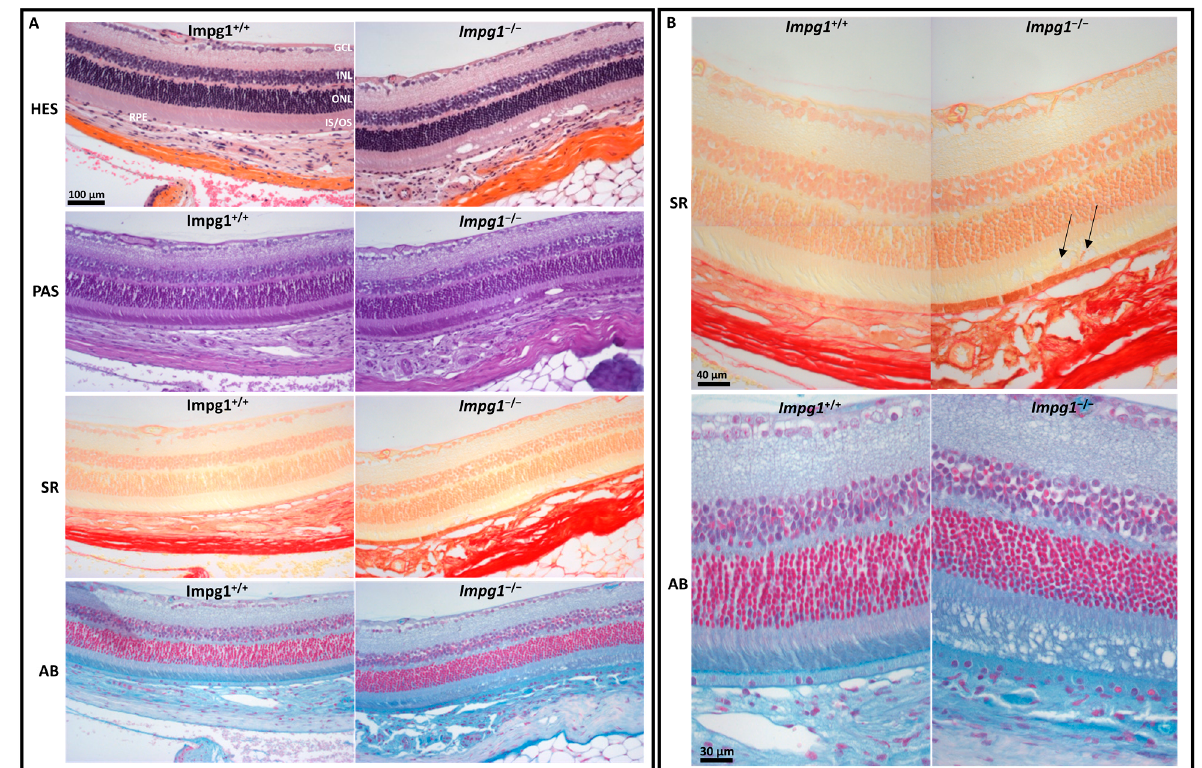
Figure 5. Disorganization of the IPM. ( A ) Histological staining of 14-month-old mouse retina showing IPM disorganization in the Impg1 − / − mice. Retinal sections were stained with Hematoxylin/Eosin/Saffron (HES), Periodic Acid Schiff (PAS), Sirius Red (SR), and Alcian Blue (AB) to evaluate the nature of the material abnormally localized in the IPM; magnification ×20. ( B ) Sirius Red confirms the presence of collagen around the vacuoles (arrows) in the IPM of Impg1 − / − mice compared to wild-type retina. Alcian Blue staining shows the loss of the vertically straight orientation of the Impg1 − / − photoreceptors, the presence of numerous vacuoles mainly in the outer segments